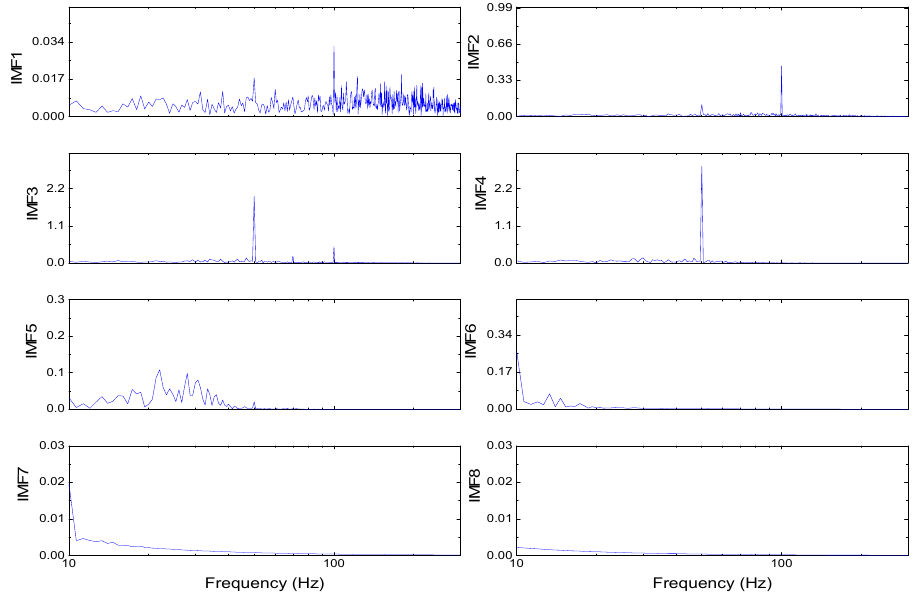
Figure 5. Components spectrograms obtained by EMD based on the C 2 Hermite interpolation algorithm.